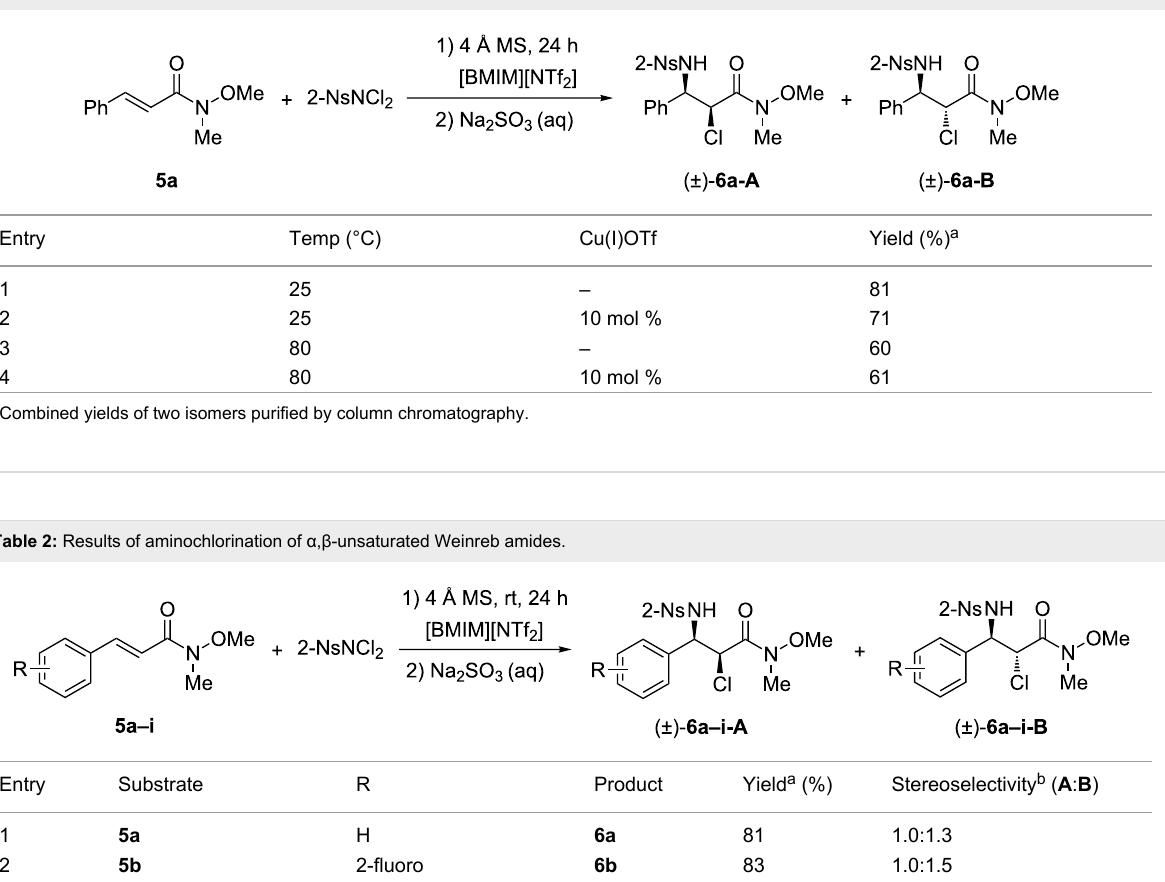
Table 1: Optimization of aminochlorination of N -methoxy- N -methylcinnamoylamide ( 5a ).